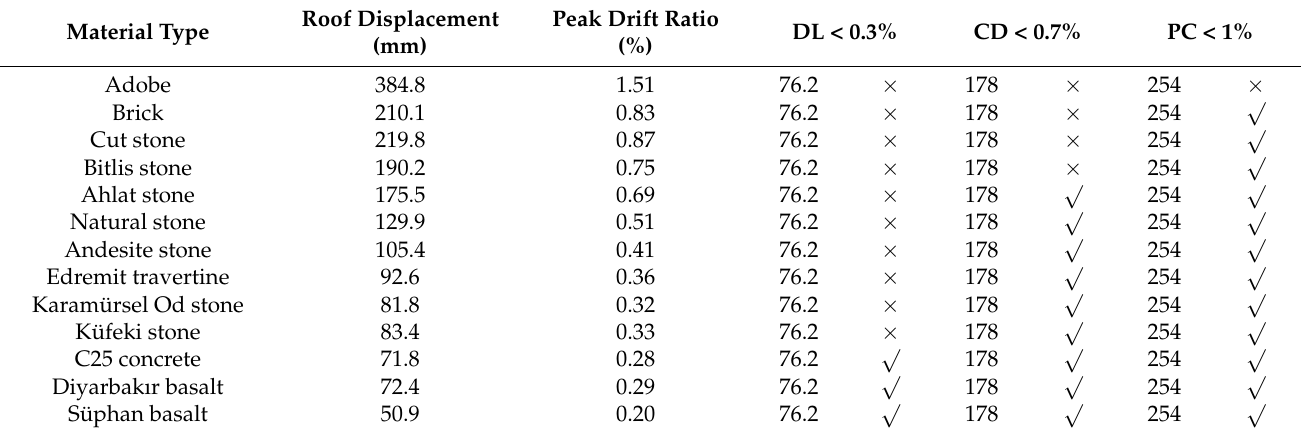
Table 14. Design earthquake displacement controls (H = 25.40 m).